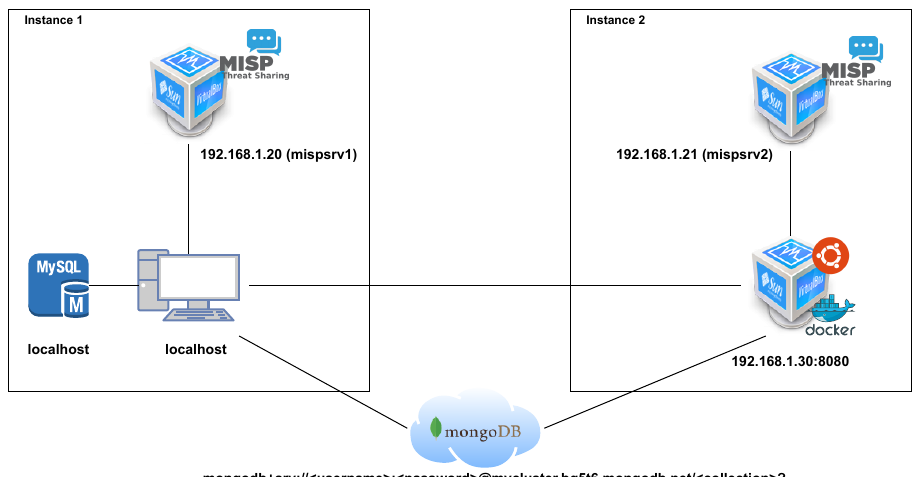
Figure 1. Implemented